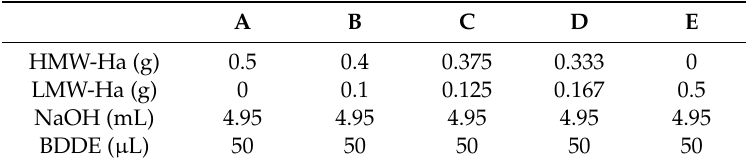
Table 7. Component list and quantities for five hydrogel samples [133].